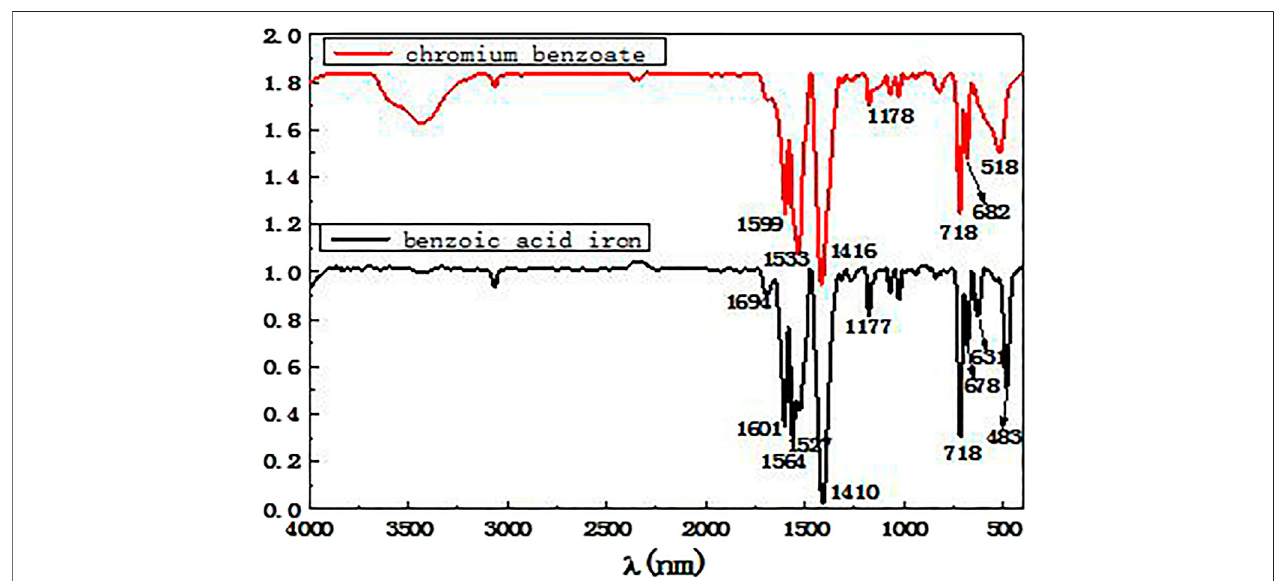
FIGURE 2 | Infrared spectra of chromium benzoate and benzoic acid iron